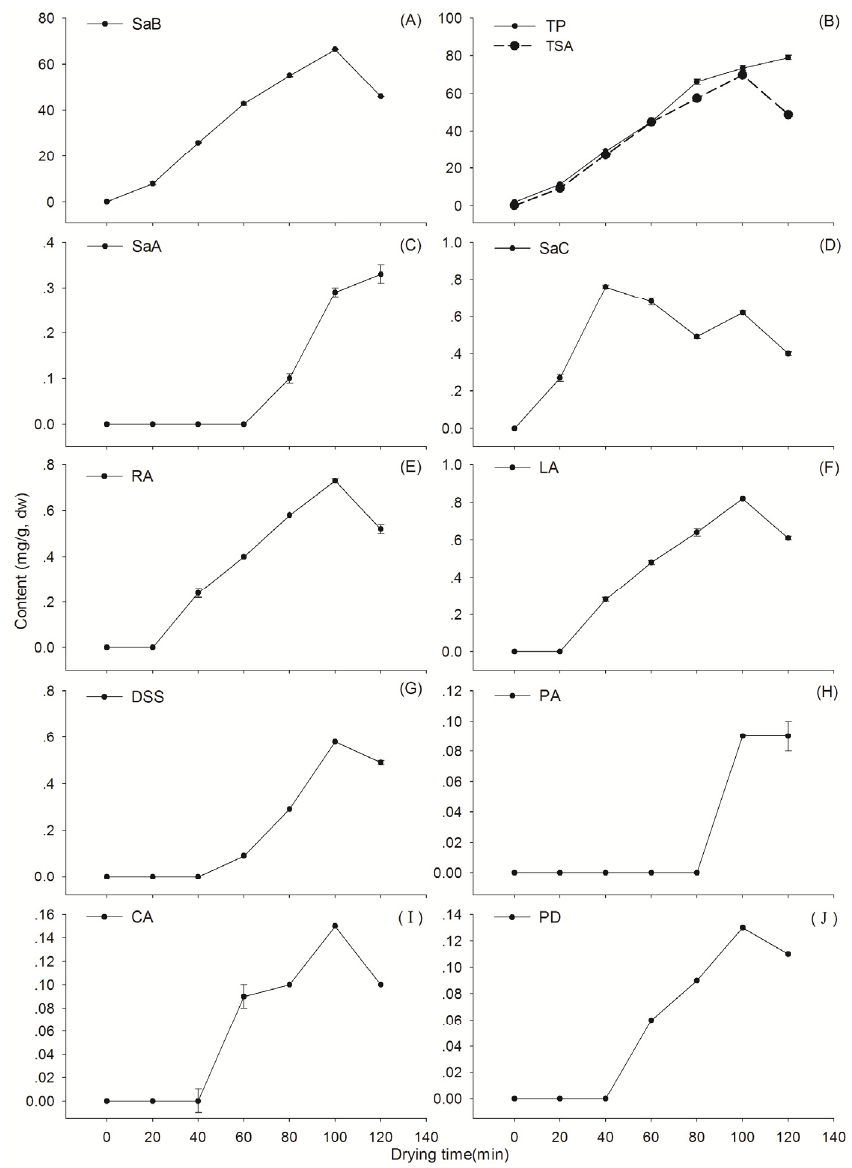
Figure 5. Plots of contents of nine different salvianolic acids in Danshen as a function of drying duration at 130 °C. See Figure 1 for abbreviations of analytes. TSA: summed values of the nine determined targets; TP: total values of phenolic acids determined by colorimetric